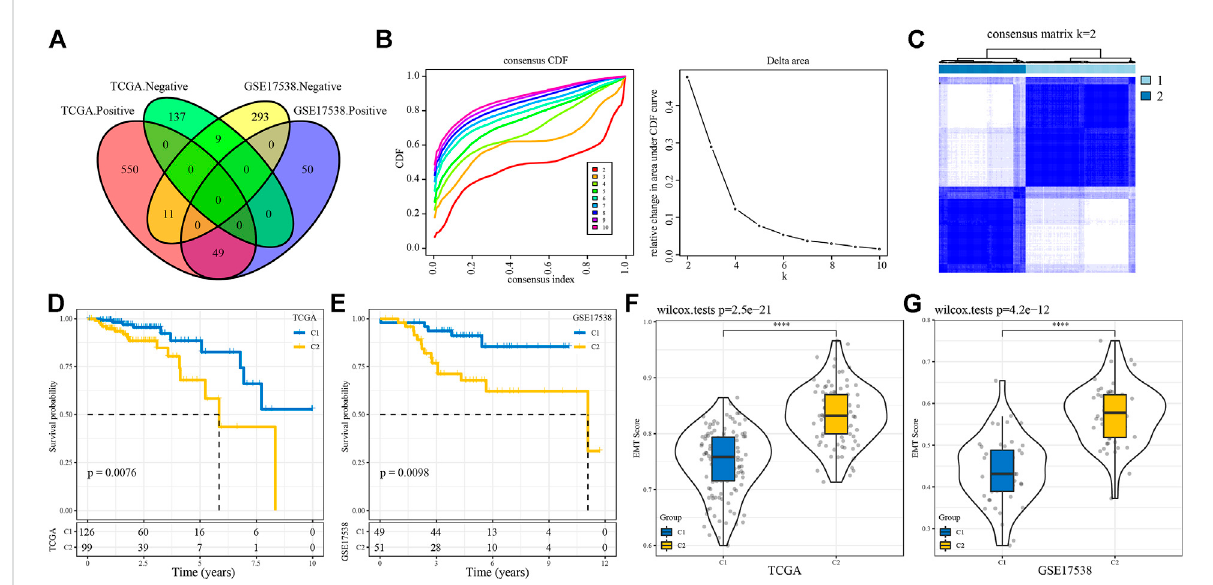
FIGURE 2 Construction of molecular subtypes based on EMT-related lncRNAs (A) Venn plot of lncRNAs positively or negatively correlated with EMT activity. (B) CDF curves of different cluster numbers (k) from 2 to 10 (C) Consensus matrix when cluster number k = 2. (D – E) Kaplan-Meier survival curves of C1 and C2 subtypes in TCGA-COAD (D) and GSE17538 (E) cohorts. Log-rank test was conducted. (F – G) Differential EMT score of C1 and C2 subtypes in two cohorts. Wilcoxon test was conducted. **** p <